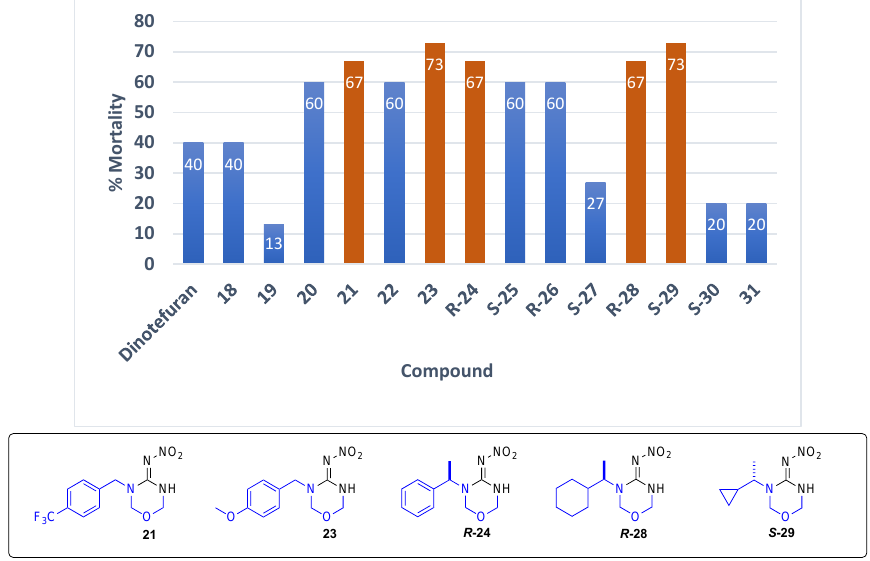
Figure 3. Analysis of cyclic nitroguanidines.